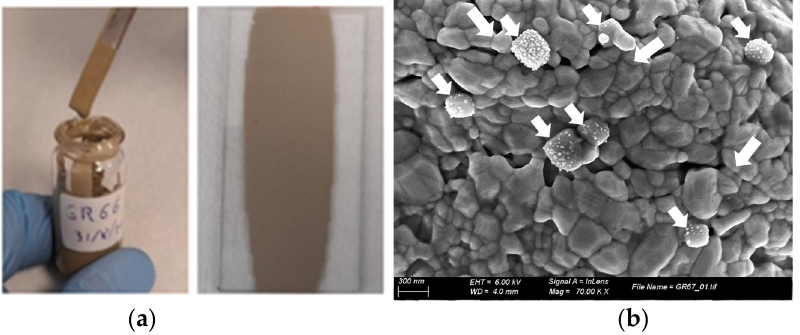
Figure 6. ( a ) Images of the formulated and printed ink by bar coating onto a glass substrate, and ( b ) SEM image of the ITEMPO3 ink after sintering at 150 °C for 30 min scaled at 300 nm, arrows mark the smaller Ag NPs (right).